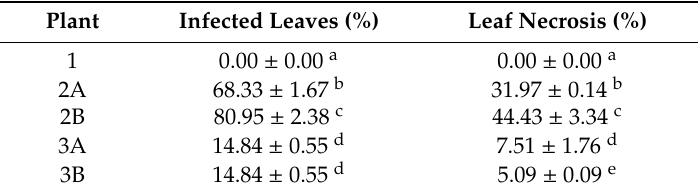
Table 5. The results of in planta antimicrobial activity assaying of the produced biocontrol agents based on B. velezensis IP22 against X. euvesicatoria strains, the causal agents of pepper bacterial